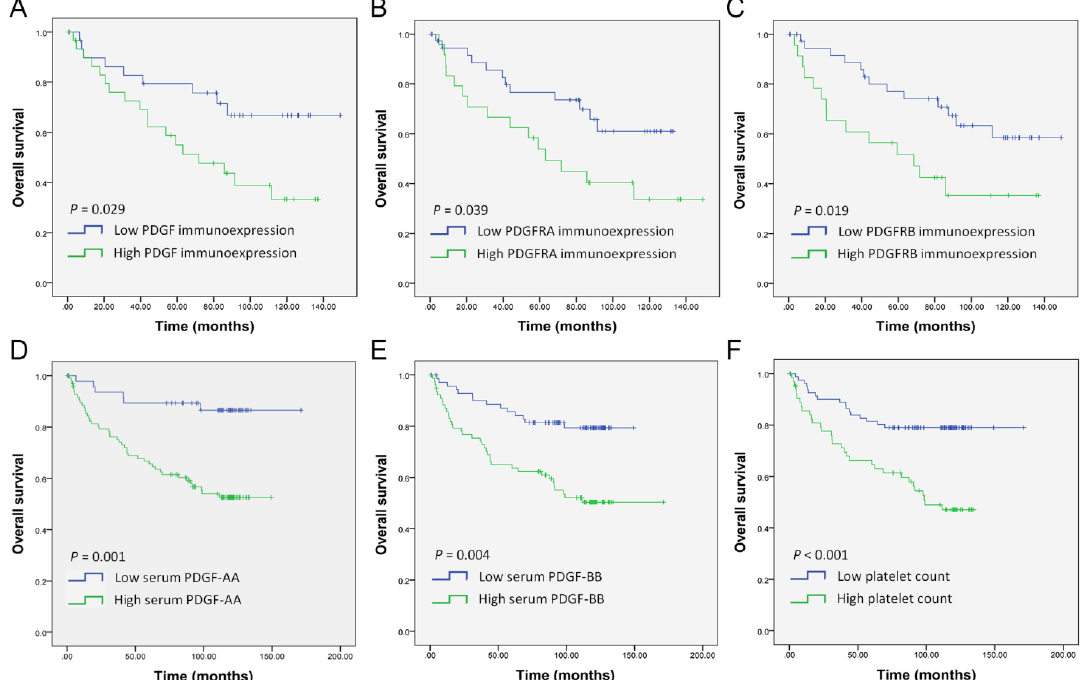
Figure 5. Kaplan–Meier analysis of OSCC patient survival according to predictive gene expression. ( A – C ) Estimation of overall survival by immunohistochemical expression of PDGF ( A ), PDGFRA ( B ), and PDGFRB ( C ). ( D – F ) Estimation of overall survival by preoperative serum levels of PDGF ‐ AA ( D ), PDGF ‐ BB ( E ), and platelet count ( F ).